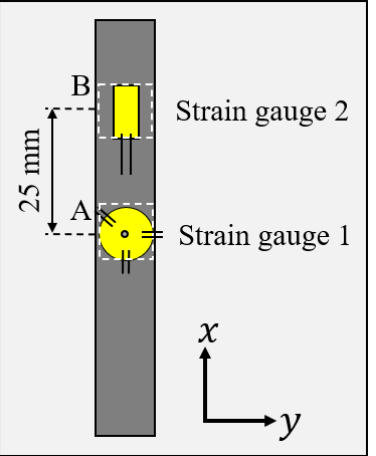
Figure 6. Strain gauge mounting